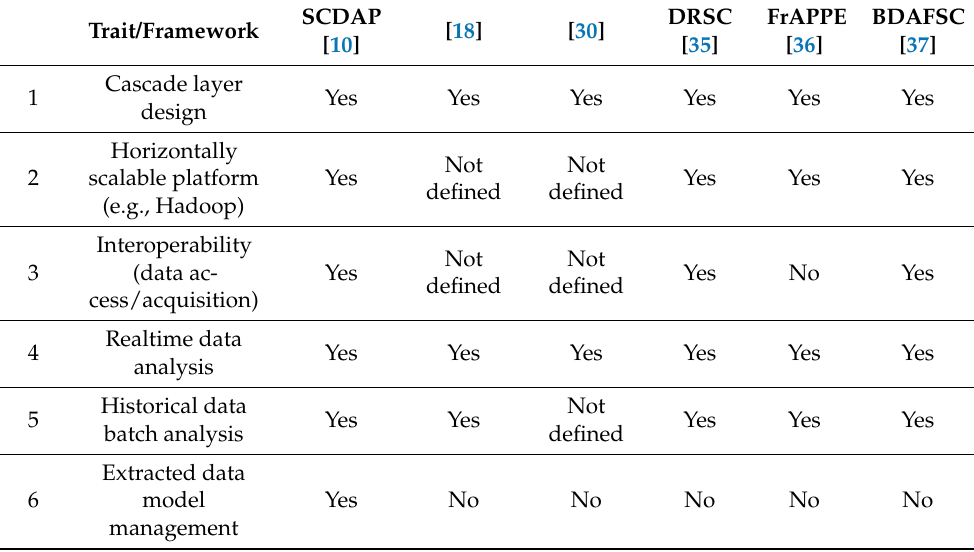
Table 2. Traits of the reviewed frameworks.